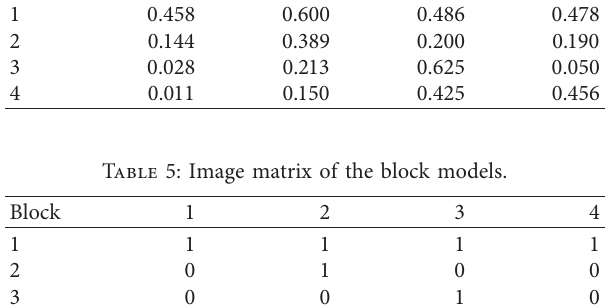
Table 4: Density matrix of the block models. Block